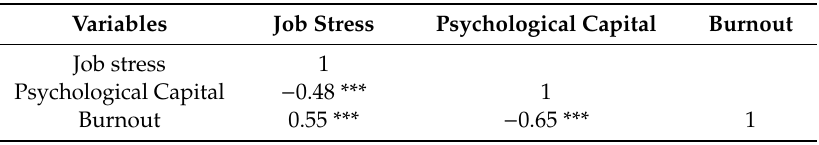
Table 3. Correlations between research variables.